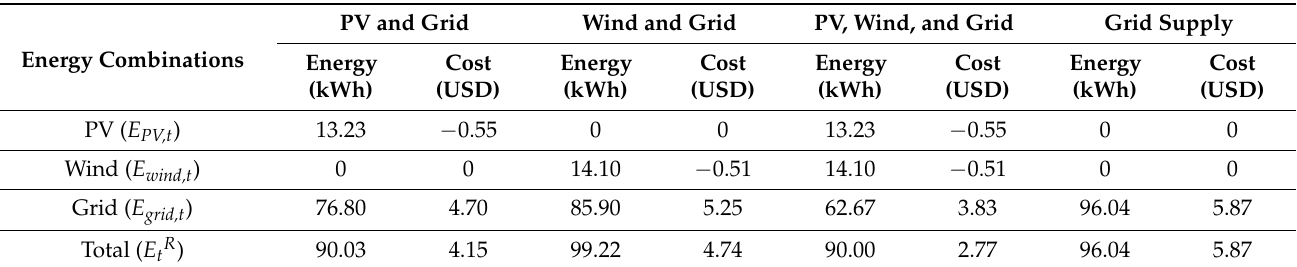
Figure 19. Wind with grid energy generation in the absence of PV. It is observed that the wind and solar power combination with grid power supply exhibit the least cost (from Equation (15)) to the consumer which is noticeably (16.69%) less than the grid supply. It is also noted that the PV, wind and grid combination provide a net energy savings of 52.81% and a portion of the grid power supply (62.67 kWh) is recorded with the least percentage of 69.63% in PV, wind, and grid combination (Table 4). Table 4. Summary of results for the different source